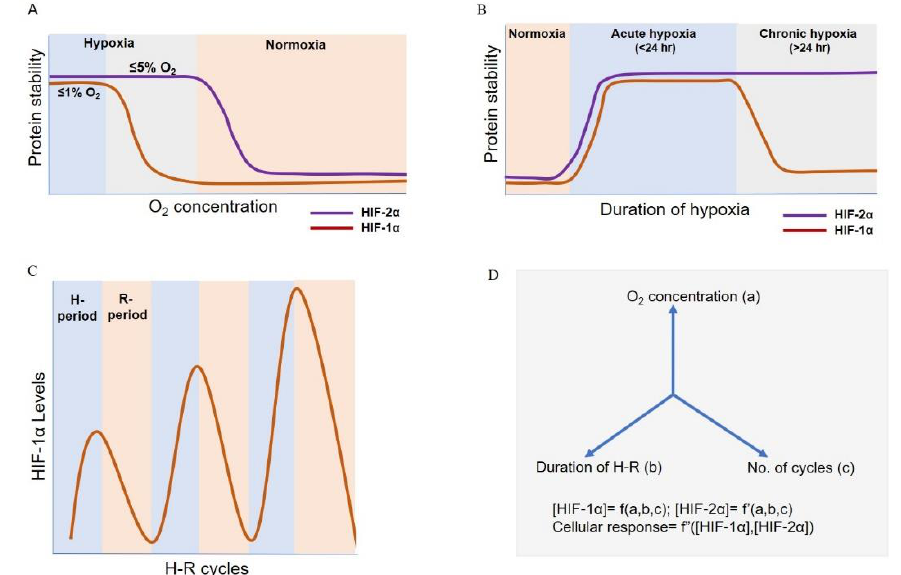
Figure 2. Dynamics of HIF-1 α / HIF-2 α stabilization under di ff erent O 2 levels and acute, chronic and cyclic hypoxia. ( A ) Stabilization of HIF-2 α over a wider range of oxygen concentration than HIF-1 α . ( B ) Stabilization of HIF-1 α under acute hypoxia and HIF-2 α under chronic hypoxia. ( C ) E ff ect of H–R periods on HIF-1 α levels under cyclic hypoxia. ( D ) Variables involved in HIF-1 α stabilization during cyclic hypoxia.